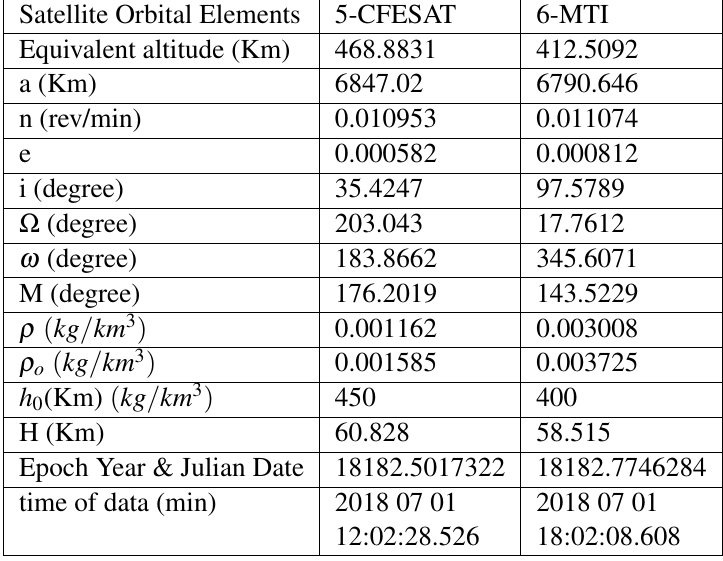
Table 2 Norad Two - Line Element Sets For The Satellites CFESAT and MTI Satellite Orbital